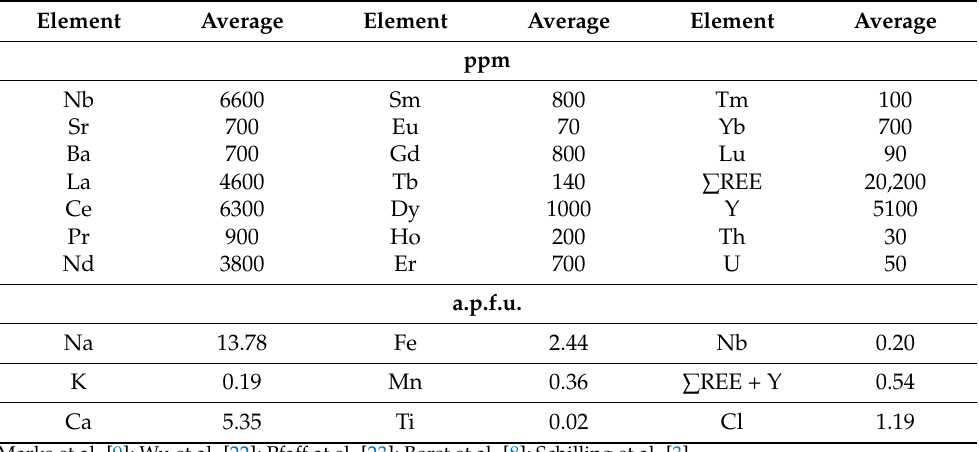
Table 2. Average compositions of EGM in Il í maussaq